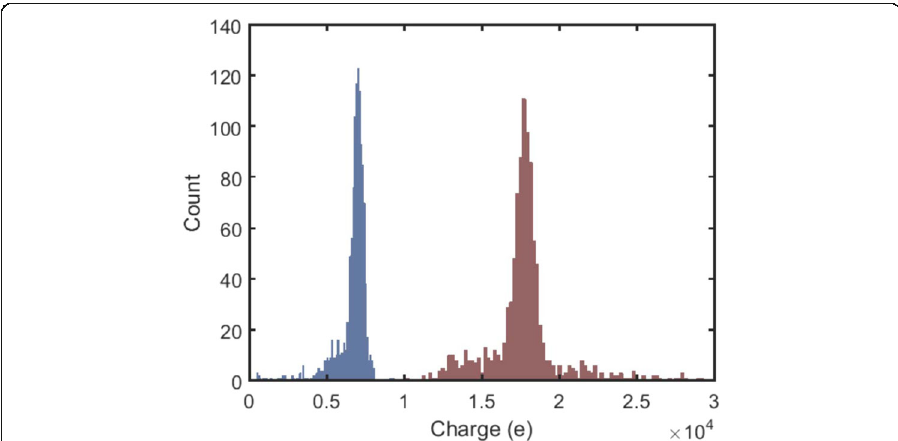
Fig. 8 Charge distribution of 510 nm PSL (blue) and 990 nm PSL (red) species, energy selected for 70 eV/z and 400 eV/z,